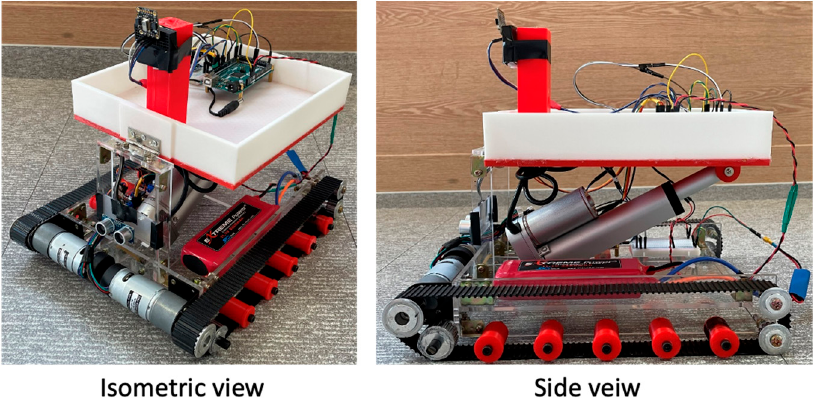
Figure 13. The prototype robot for the experiment.